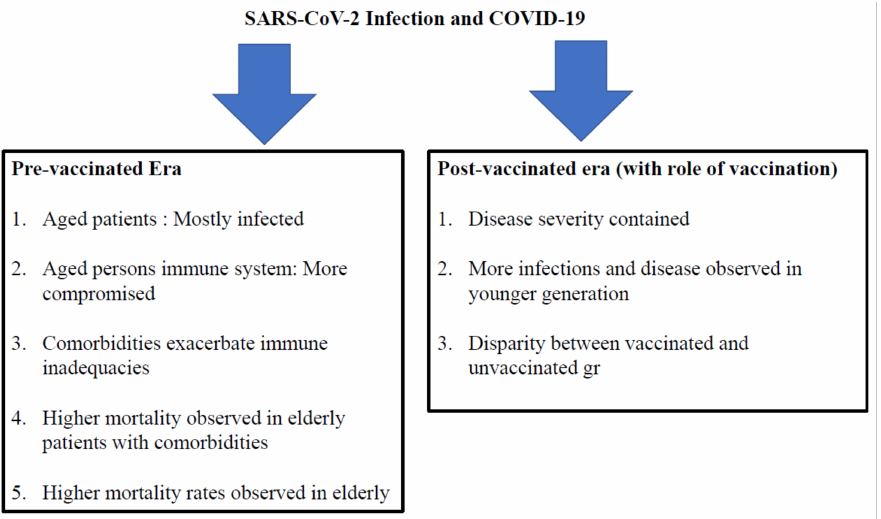
Figure 1. SARS-CoV-2 infections in different eras of the